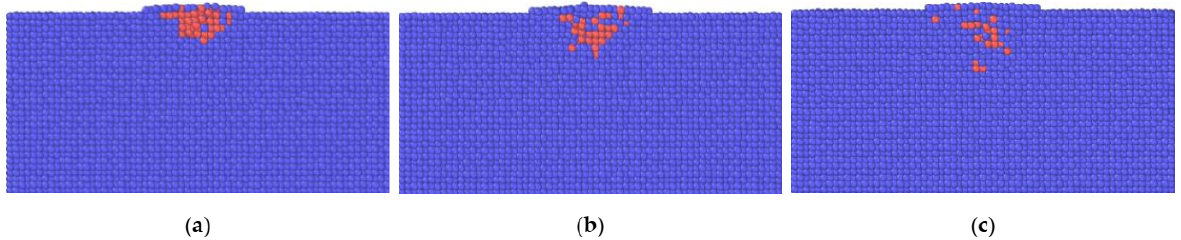
Figure 7. Morphology snapshots (side views of the center section along x–z plane) of Cluster 0 and substrate after impacting at the different T x ,0 in Model 1: ( a ) T x ,0 = 1 ev, ( b ) T x ,0 = 50 ev and ( c ) T x ,0 = 100 ev. In all cases, V z ,0 = 600 m/s and T z ,0 = 0